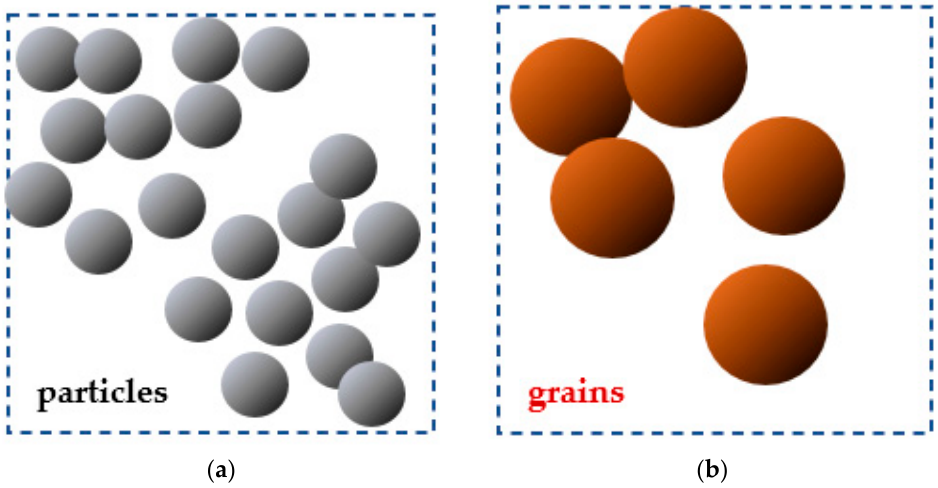
Figure 2. Elements tracked in DEM simulations: ( a ) elementary particles in a given volume; ( b ) coarse-grain particles (“grains”) in the same volume. The level of coarse-graining and the characteristics of the link between representative and original particles depend on the specific approach.